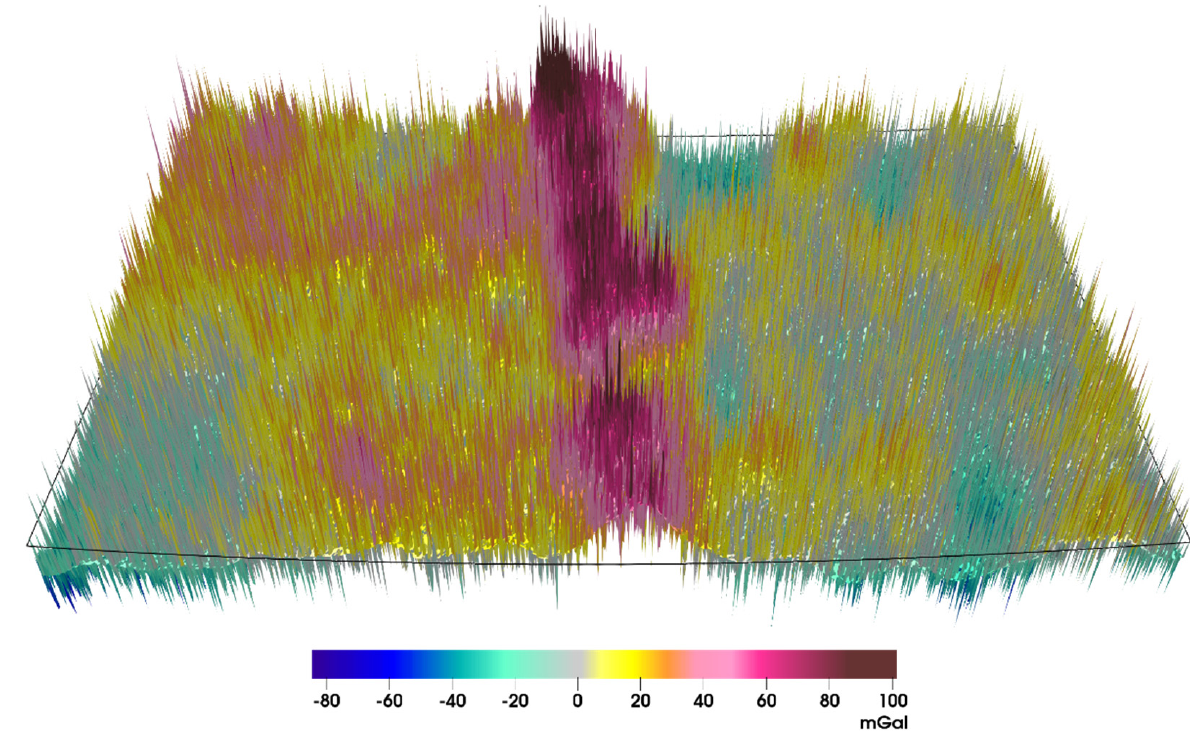
Figure 12. Noised observed field.